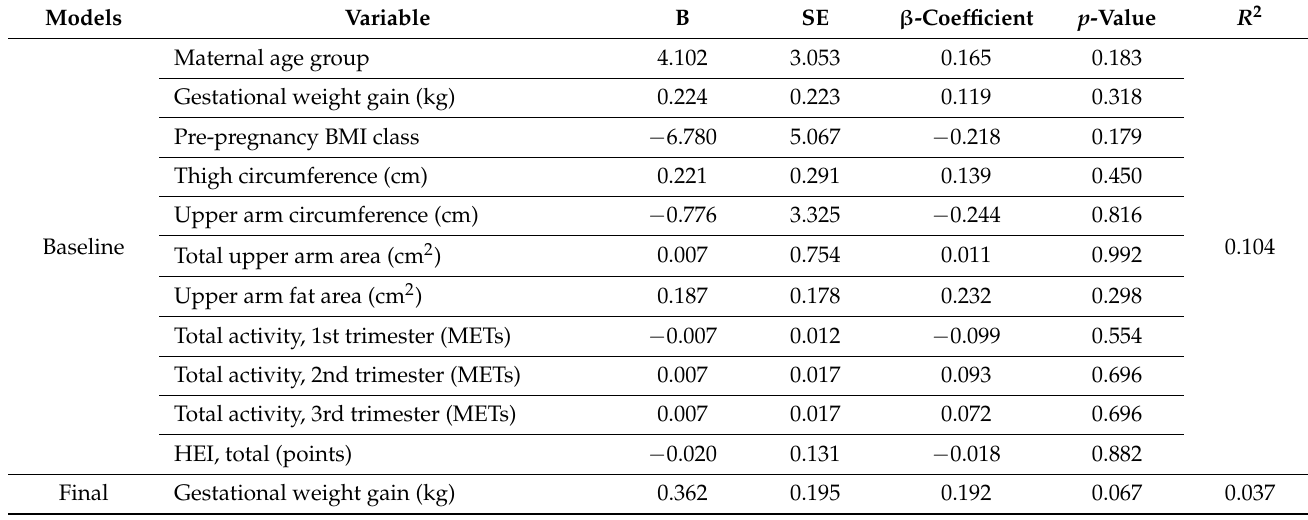
Table 7. Multiple linear regression: Adiponectin as an outcome variable (baseline and final model, n = 92).